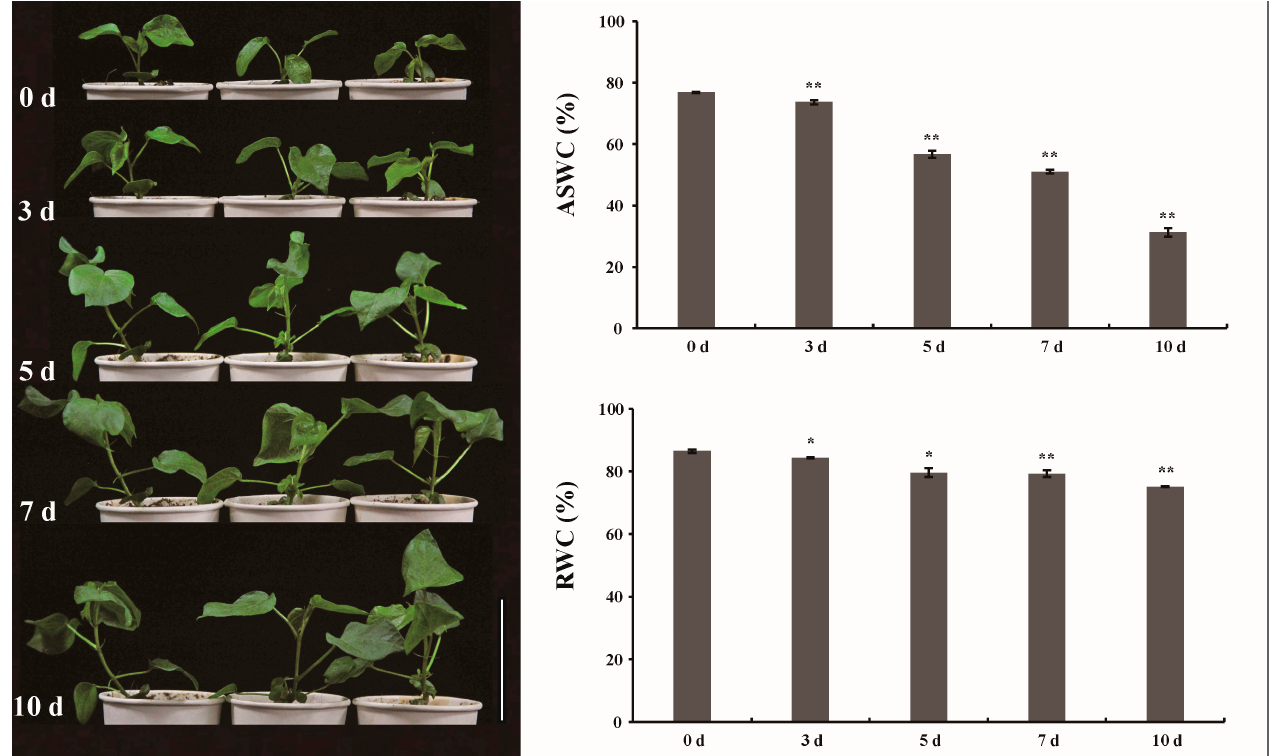
Figure 1. Phenotype of drought-stressed G. anomalum seedlings, the RWC of G. anomalum seedlings and ASWC. RWC: the relative water content of G. anomalum seedlings, ASWC: absolute soil water content. * p < 0.05, ** p < 0.01, Student’s t test.